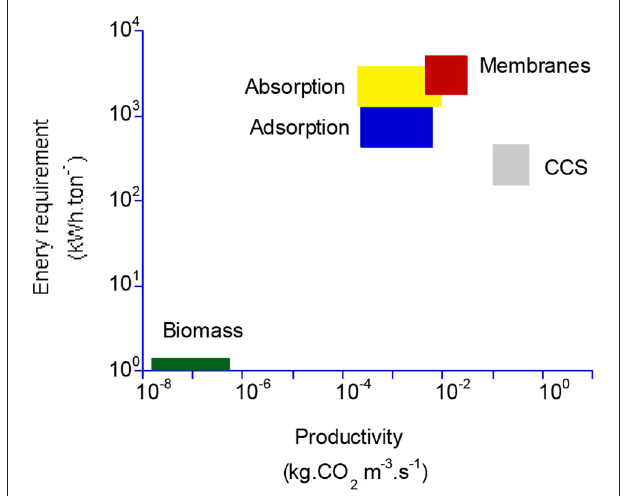
FIGURE 10 | Tentative map showing the energy and productivity performances of different DAC processes, compared to biomass and CCS. The range of performances for each technology is based on a very limited number of studies and should not be considered definitive. The very broad range of the two indicators is noticeable. Compared to biomass productivity in terms of carbon storage (Xu et al., 2014), DAC technologies offer a strong increase at the expense of a very large energy